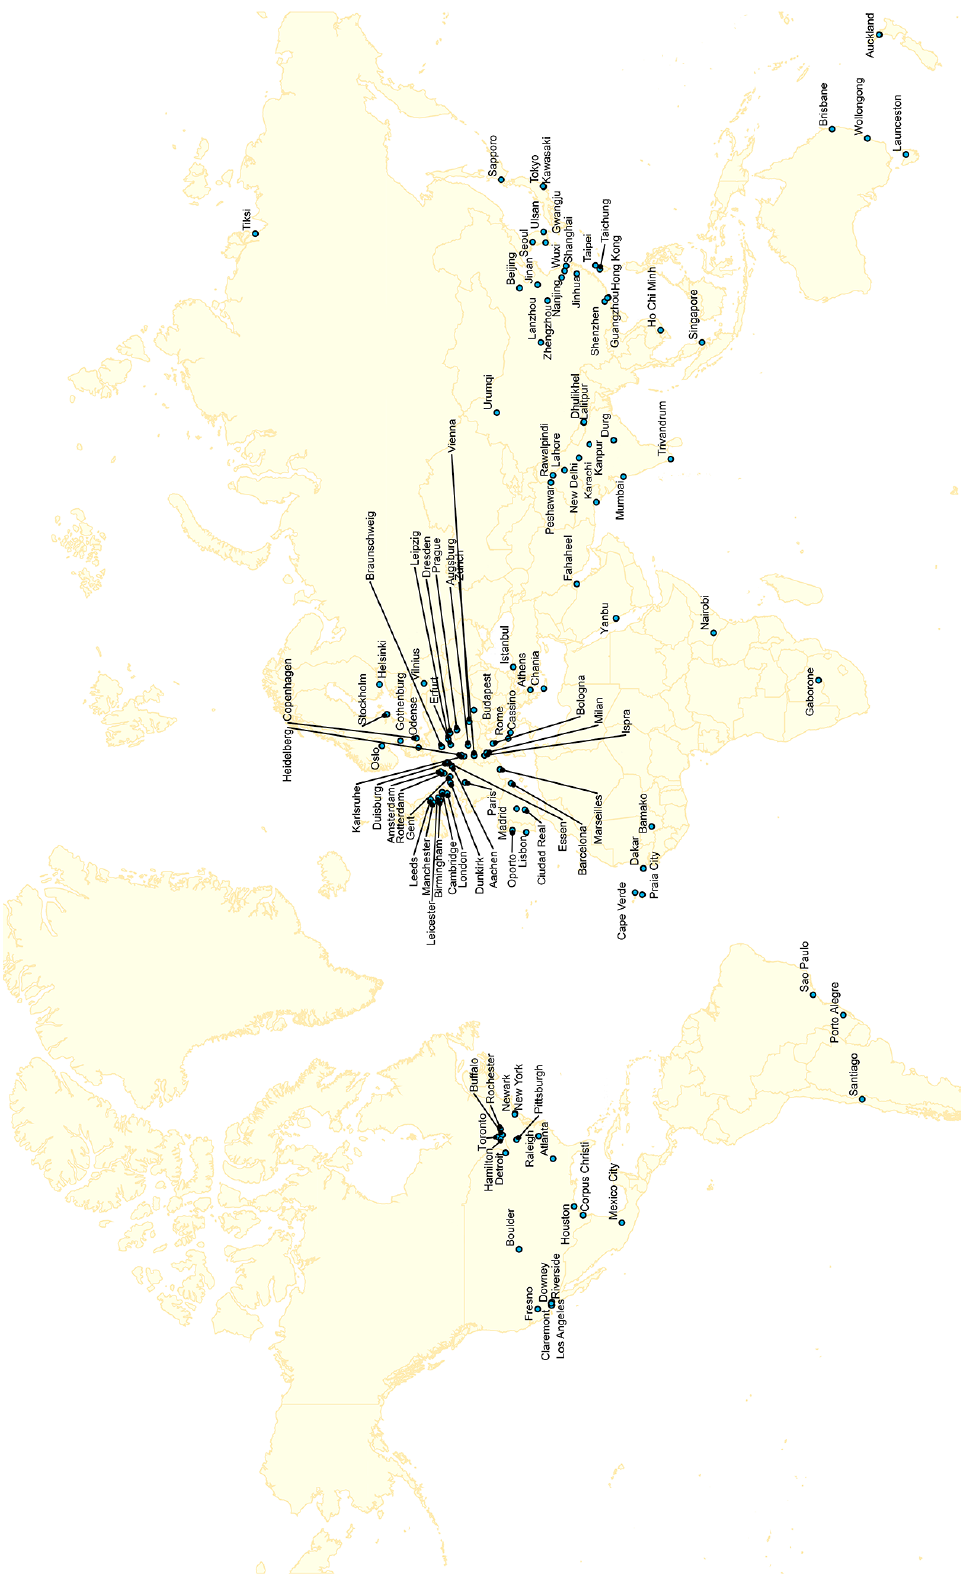
Figure 5. Global distribution of urban aerosol PSD measurement locations included in this study.